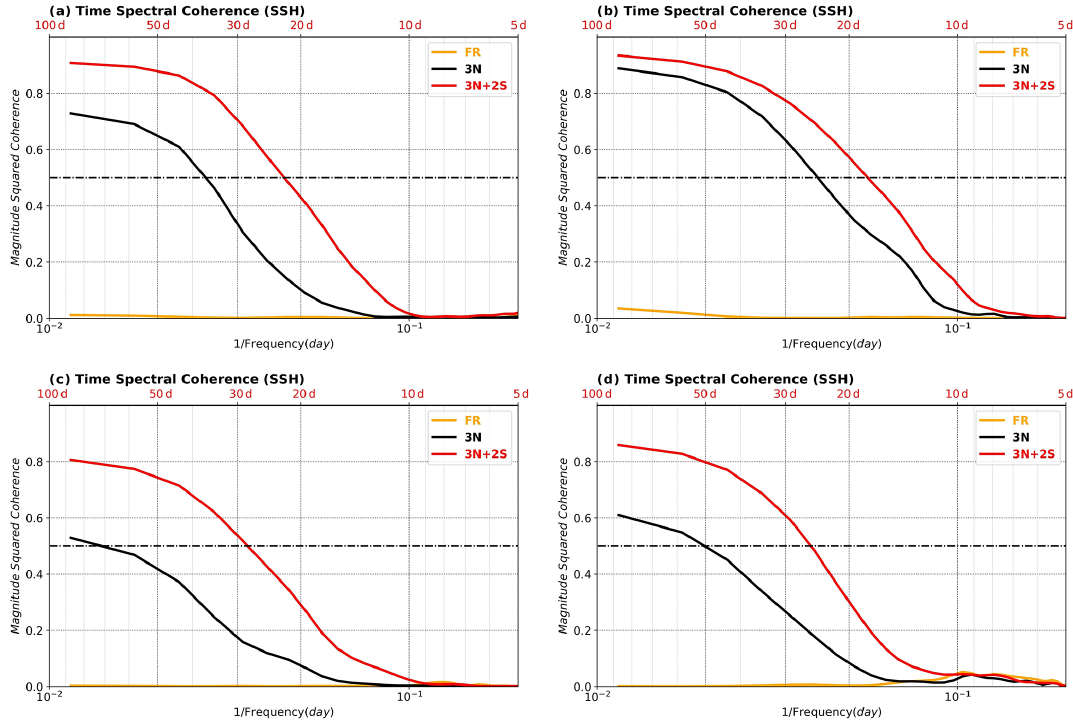
Figure 12. Time spectral coherence with respect to the NR (wavelengths < 500km), (a) low-latitude region (red box), (b) Agulhas current (orange box), (c) North Atlantic (high-latitude, green box) and (d) North Atlantic Drift current (black box).